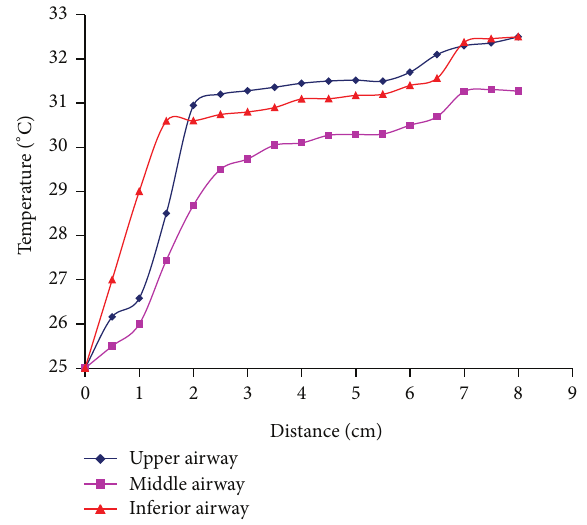
Figure 3: Different heating streamlines of airflow in three nasal airways of a selected nose. The blue, purple, and red lines show, respectively, the heating effect of air streamline in the upper airway, middle airway, and inferior airway.